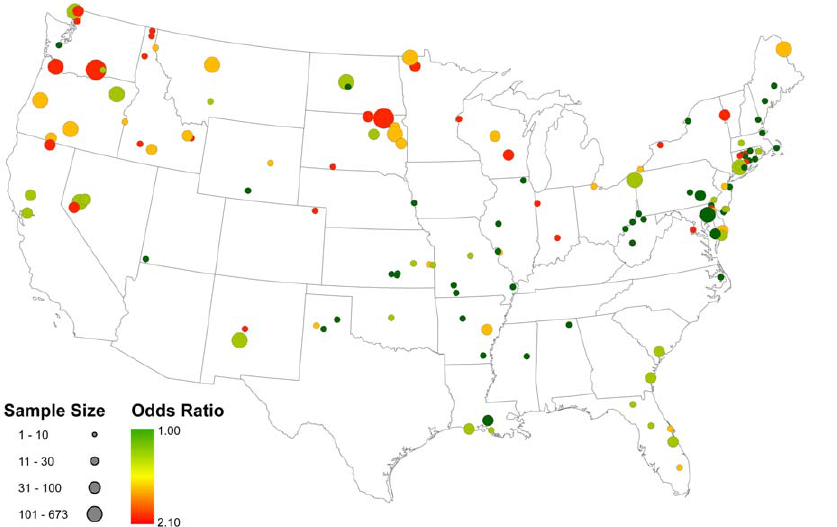
Figure 4. Map showing the odds ratio for the overwintering season interval apparent prevalence effect resulting from the top model fit to the data. The sample size reflects the number of AIV samples collected within each of the 137 local watersheds used in this analysis and the colors reflect the mean odds ratio of testing positive for AIV, with red indicating the odds of testing positive are more than twice that of points colored dark green based on this variable.